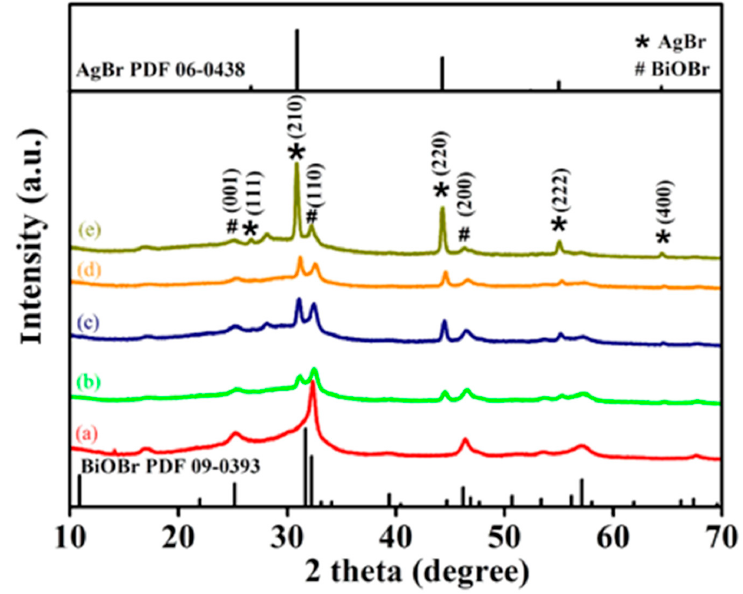
Figure 1. X-ray di ff raction (XRD) patterns of the as-fabricated samples: ( a ) BiOBr / PAN CMs; Figure 1. X-ray diffraction (XRD) patterns of the as-fabricated samples: ( a ) BiOBr/PAN CMs; ( b ) ( b ) AgBr / BiOBr / PAN CMs-1; ( c ) AgBr / BiOBr / PAN CMs-2; ( d ) AgBr / BiOBr / PAN CMs-3; AgBr/BiOBr/PAN CMs-1; ( c ) AgBr/BiOBr/PAN CMs-2; ( d ) AgBr/BiOBr/PAN CMs-3; ( e ) ( e ) AgBr / BiOBr / PAN AgBr/BiOBr/PAN CMs-4.